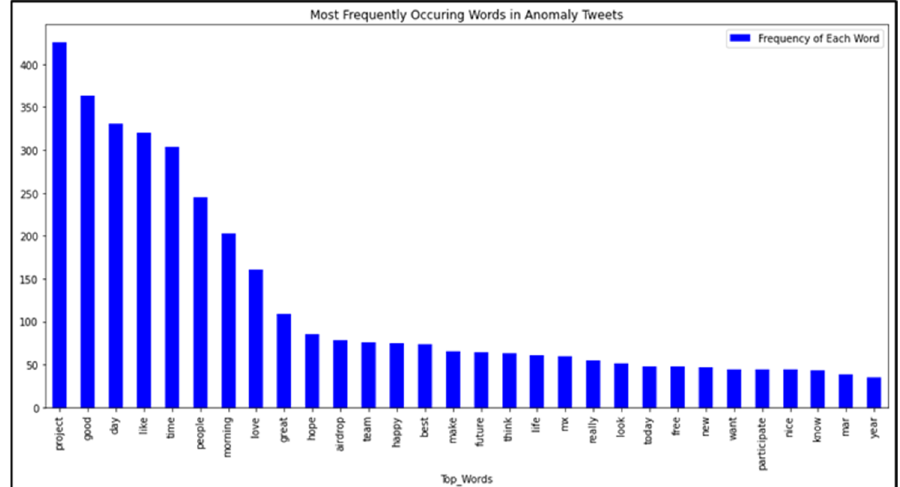
Figure 4. Word Cloud for Cluster 0 of the most dominant tweets.